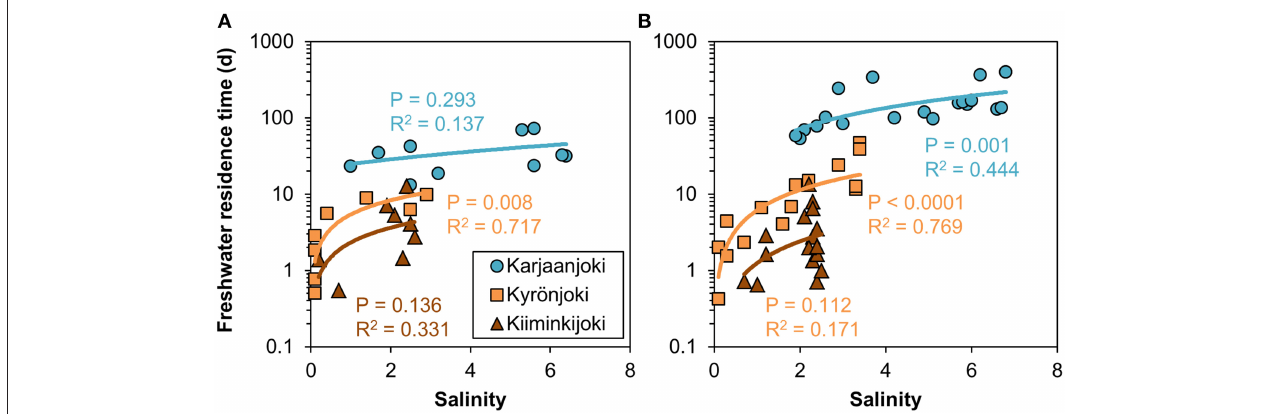
FIGURE 2 | Relationships between freshwater residence time and salinity in the three study estuaries during (A) high (spring) and (B) low (summer and autumn) river discharge conditions. Non-linear power regression models were fitted to